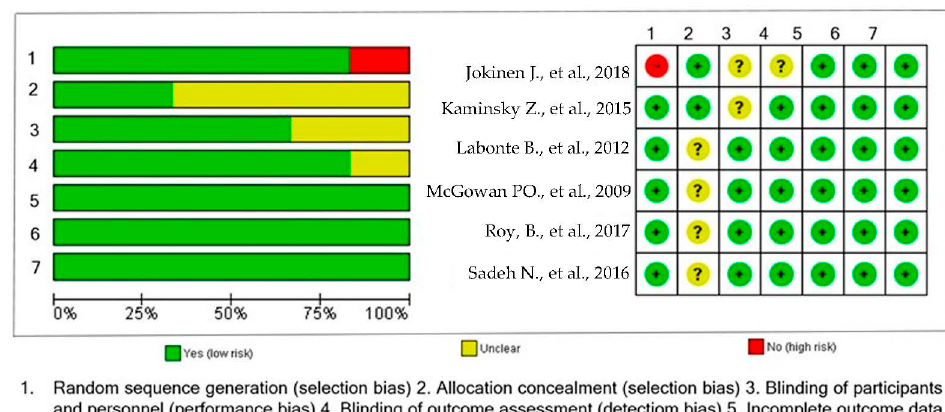
Figure 2. Risk of bias summary: a review of authors’ judgments about risk of bias item for each included study [20–25].